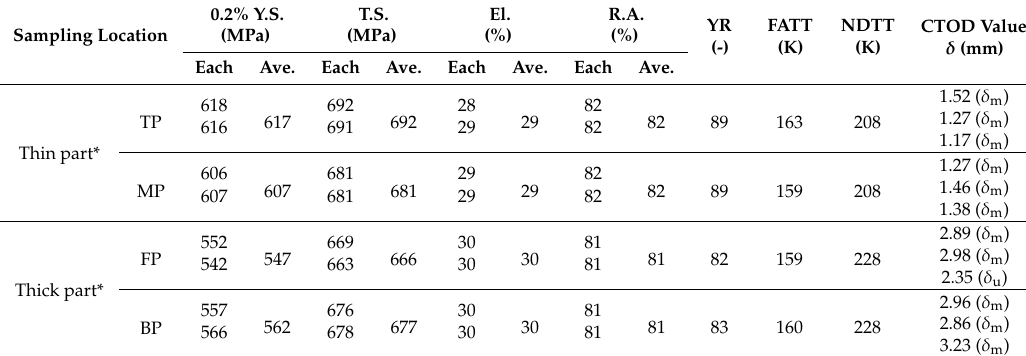
Table 4. Typical production test results in a trial